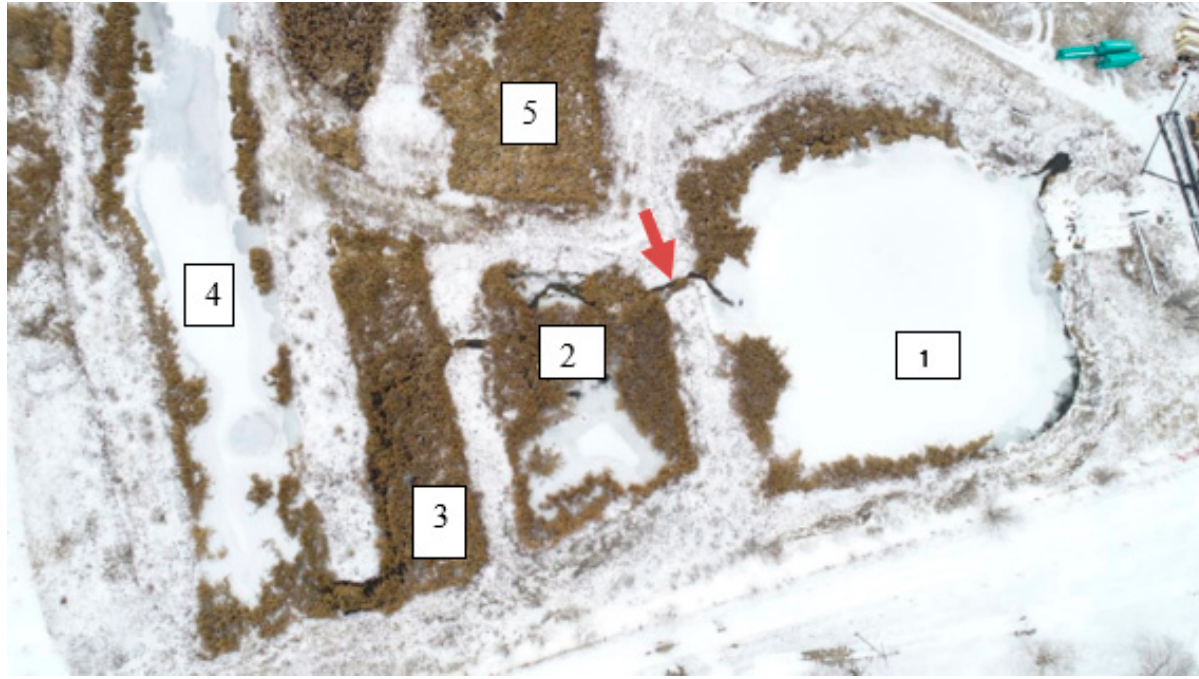
Figure 2. WTP wastewater holding ponds with flow of water in the direction of ponds 1 through 5. Samples for laboratory experiments were collected at the location identified with the red arrow. Pond depths range from 1–2 m with each pond capable of retaining a maximum of 5000 m 3 of WTP wastewater; retention time is calculated at 3–5 d depending on time of year and consumption rates. The ponds were originally constructed in the 1970s to provide physical settling of suspended solids and consumption of free chlorine residuals. Holding ponds were covered in ice and snow at the time of sample collection.